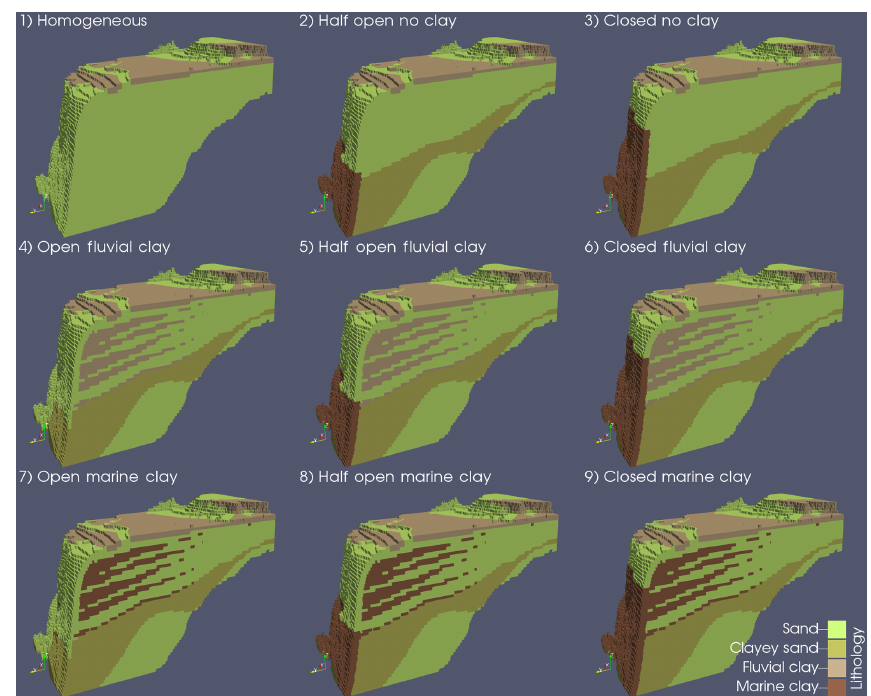
Figure 2. Snapshots of the lithological model scenarios that are used as input for the numerical variable-density groundwater flow model. The eastern half of the model is plotted here (see Fig. A1 for the extent). The first word refers to the connection to the sea of the deeper part of the NDA, the second word to the assigned hydraulic conductivity of the onshore-reaching clay